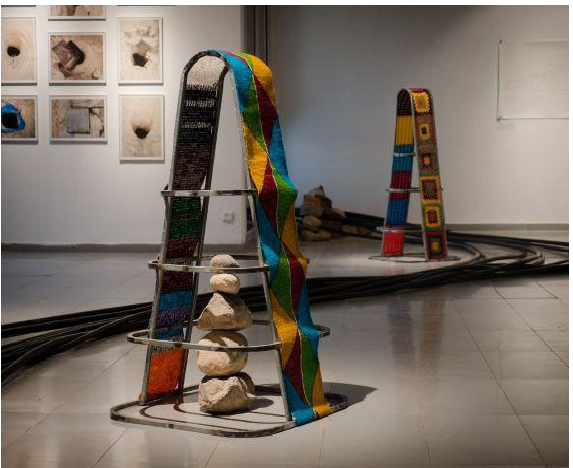
Figure 10. “ Common Views: Sourcing Water ” Exhibition, ACAC, Arad, 2020. Shown here are sculptures and artwork which touch on the living conditions in the desert, Curated by: Irit Carmon Popper. Photographed by Dan Farberoff. Image courtesy of the artist.